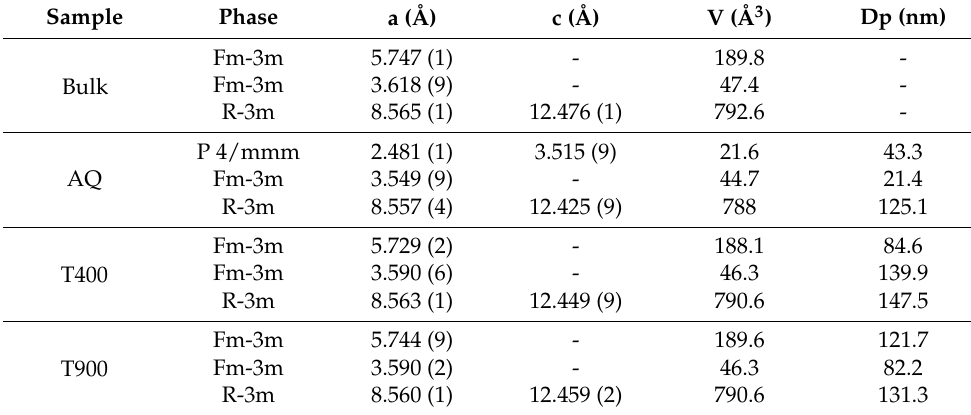
Table 2. Crystalline phases and lattices parameters, extracted from XRD